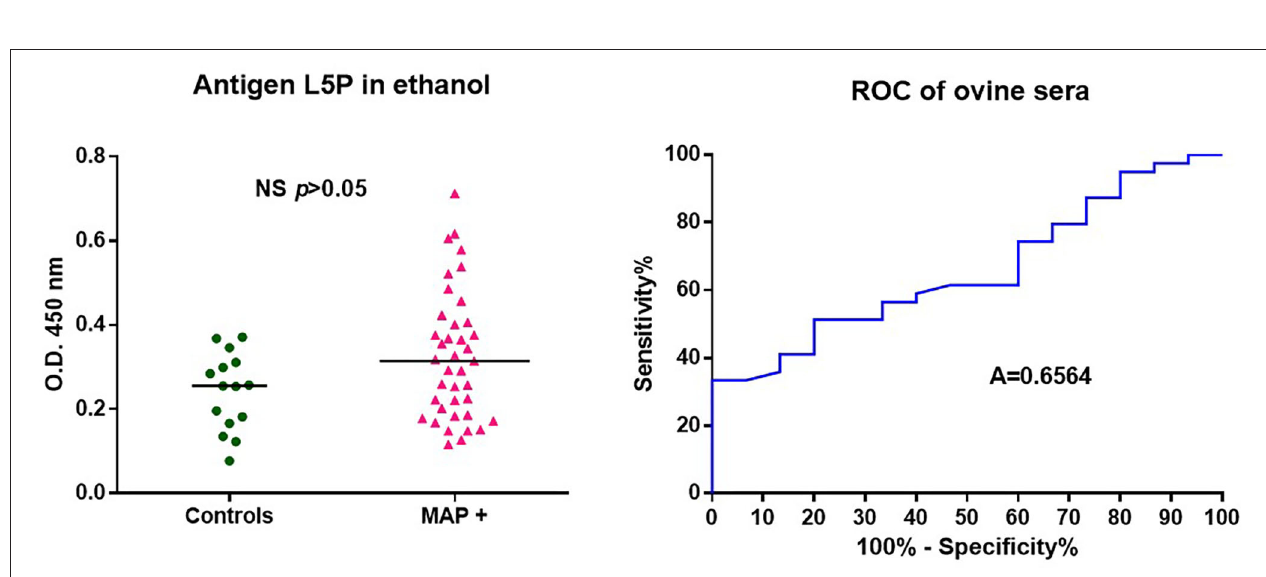
FIGURE 3 | ROC analysis of antibody response of ovine sera against L5P. Analysis performed on a panel of sera from 39 MAP positive (MAP + ) and 15 control animals, using L5P coated in ethanol. All results are expressed as individual OD and were compared by ROC analysis. The horizontal bars indicate median. Area under the receiver operating characteristic curve. Significantly different when p < 0.05. Not significantly different (NS).